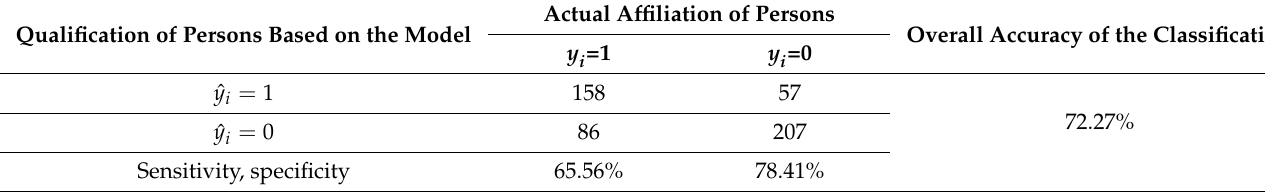
Table 5. Classification accuracy of the logit model.